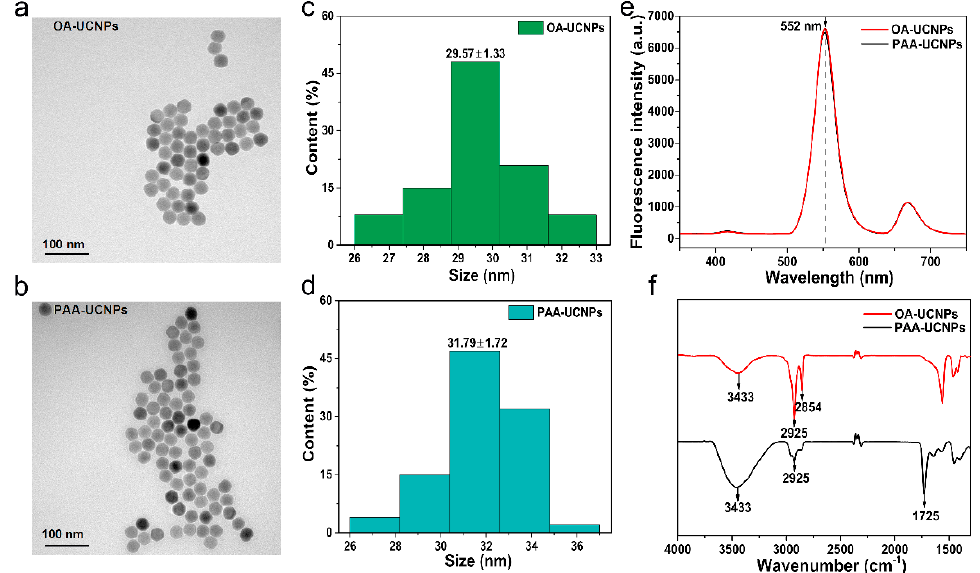
Figure 3. Characterization of the NaYF 4 : Yb, Er UCNPs. ( a , b ): Transmission electron microscope (TEM) image of NaYF 4 : Yb, Er UCNPs, ( c , d ): Size distribution of NaYF 4 : Yb, Er UCNPs, ( e ): Fluores- cence spectrums of NaYF 4 : Yb, Er UCNPs (under 980 nm excitation), ( f ): Fourier transform infrared (FTIR) spectrums of NaYF 4 : Yb, Er UCNPs.